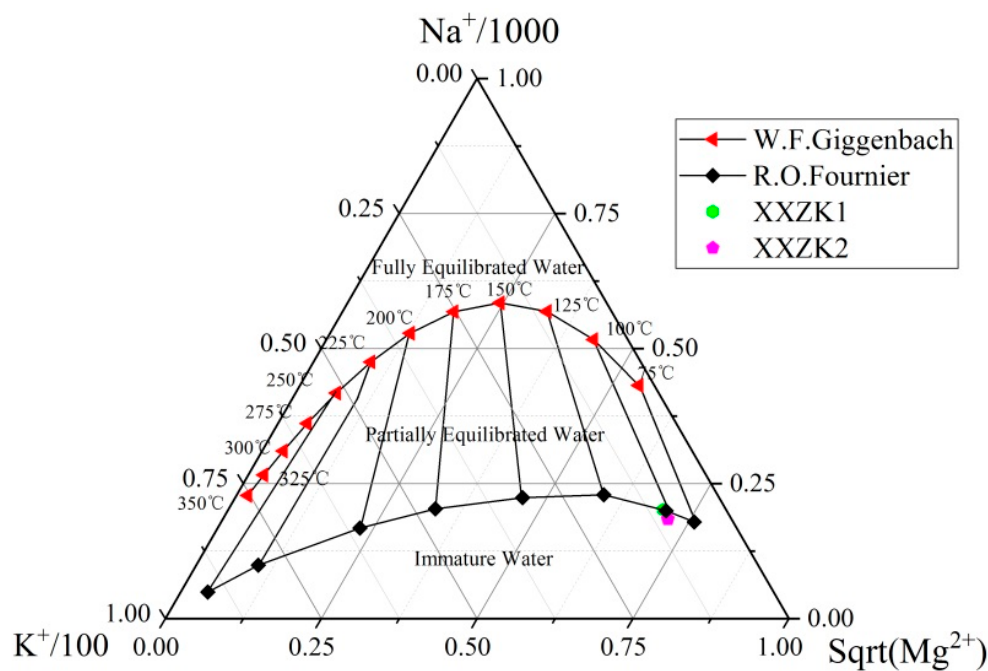
Figure 6. Na-K-Mg ternary diagram of geothermal waters in Xianxian County . Table 2. Hydrochemical analysis of geothermal waters from wells XXZK1 and XXZK2 .